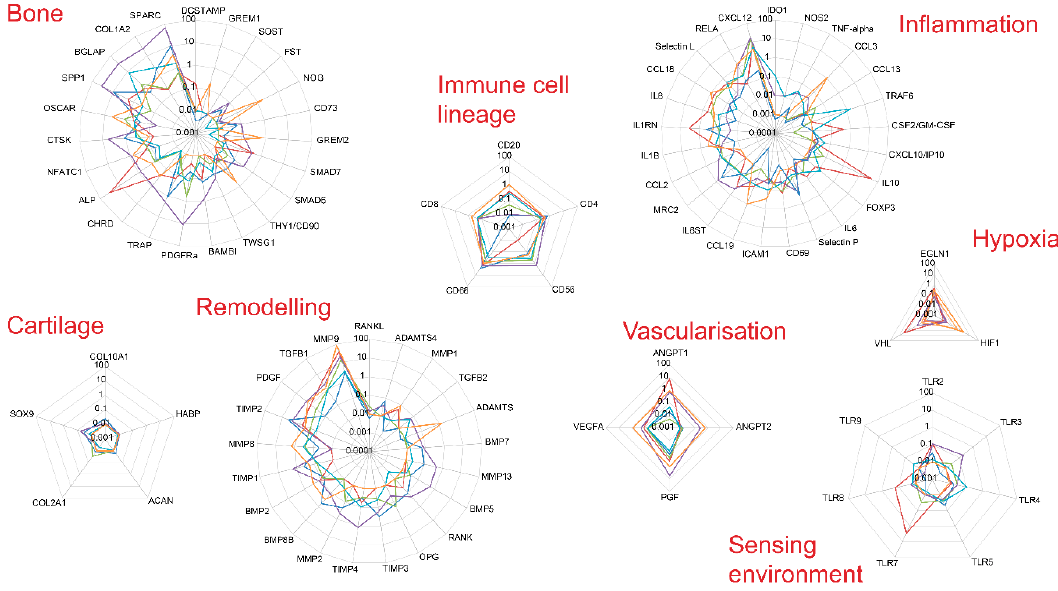
Figure 3. Gene expression levels in six biopsies from healthy bone. Gene expression levels were determined by qPCR. Genes were grouped by themes.